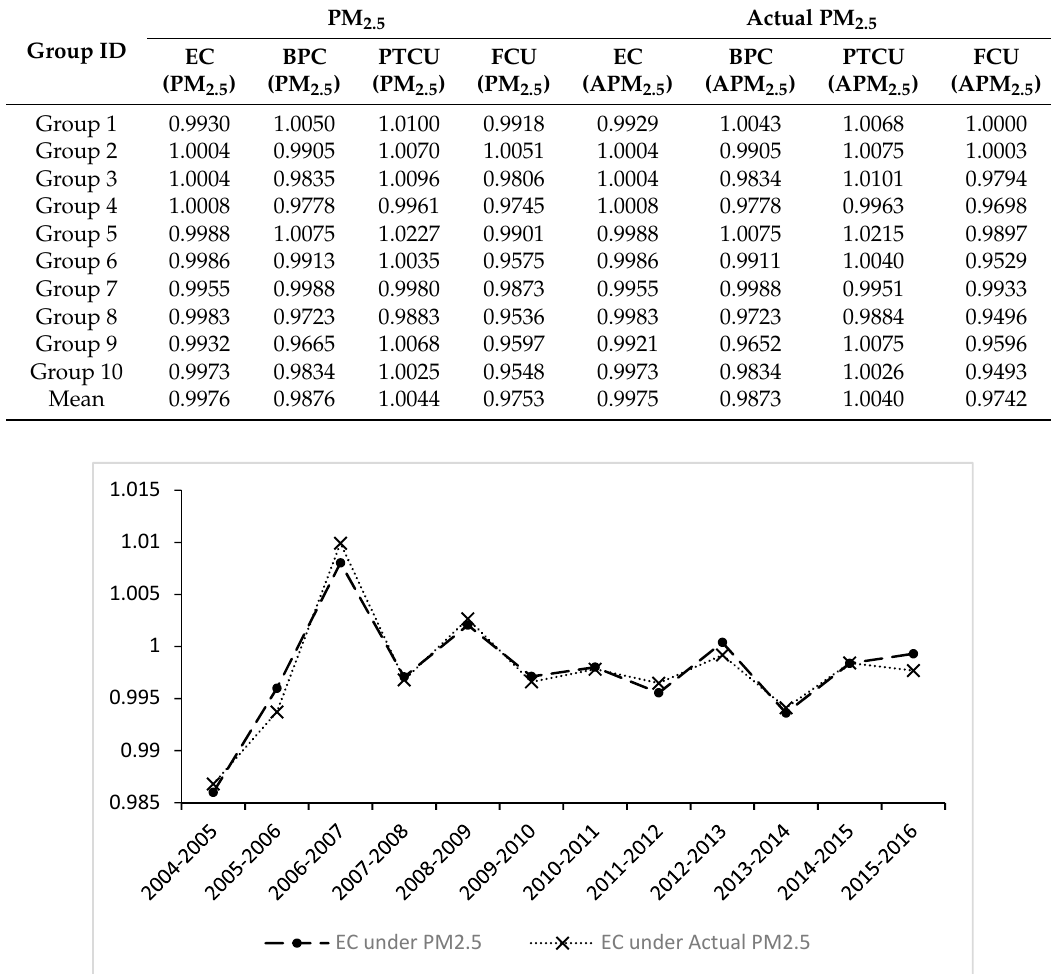
Figure 2. The dynamic trend of efficiency change (EC) index under PM 2.5 (diameter of fine particulate matter less than 2.5 µ m) and actual PM 2.5